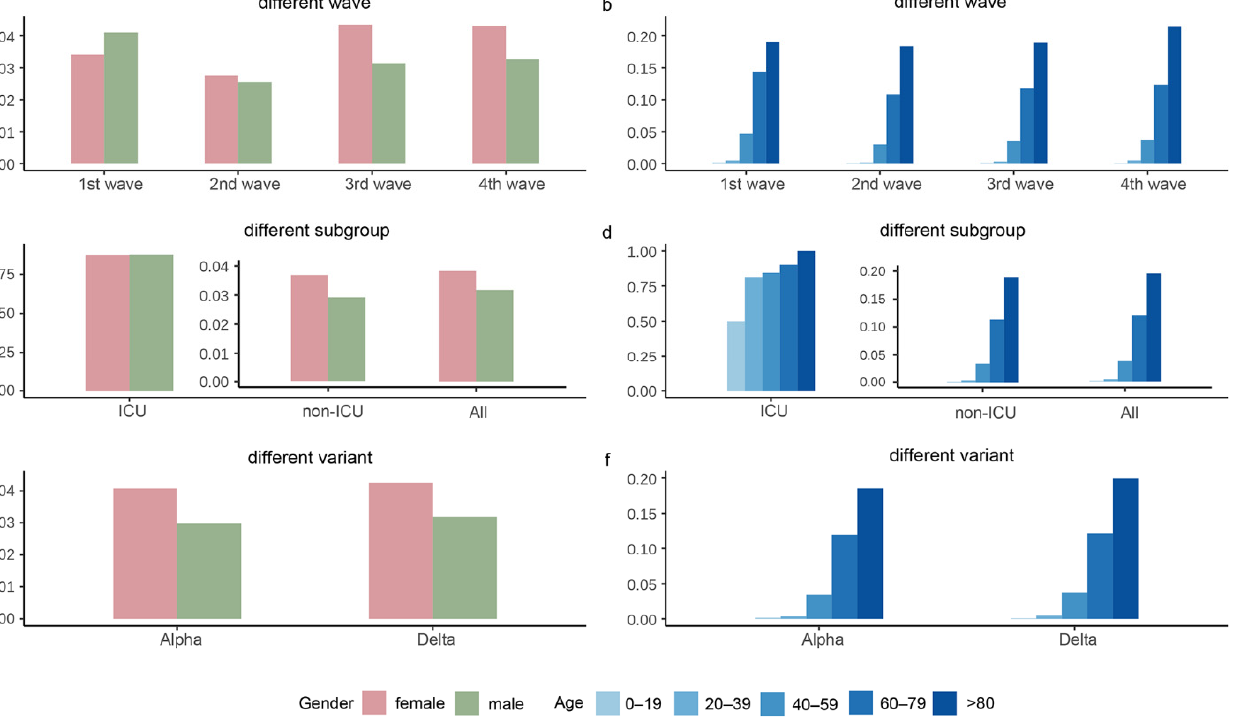
Table 2 gives the median estimates and 95% CIs of SOR/SOD. The log-logistic distribu- tions provided the best fit for SOR and SOD. The estimated median of SOR was 27.6 days for ICU cases and up to 247.0 days, while the median was 17.0 days for non-ICU cases and the longest was just 56.1 days. The SOD of ICU cases was 1.5 days shorter than that of non-ICU cases (6.9 vs. 8.4 days). Cases during the Delta period had shorter SOR and SOD than that during the Alpha period (15.0 vs. 16.0 days, 9.2 vs. 9.7 days). Figure 4 showed that the best-fitted distribution of SOR and SOD were left-skewed in different subgroups, and both SOD and SOR had long right